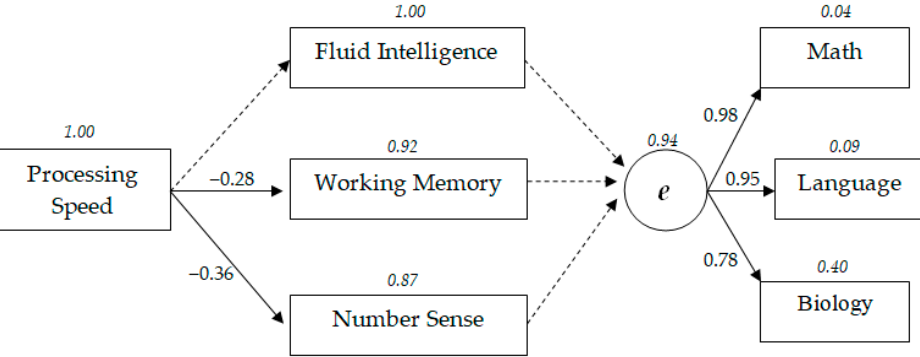
Figure 3. Model with relationships between cognitive abilities and general academic achievement in high school education.